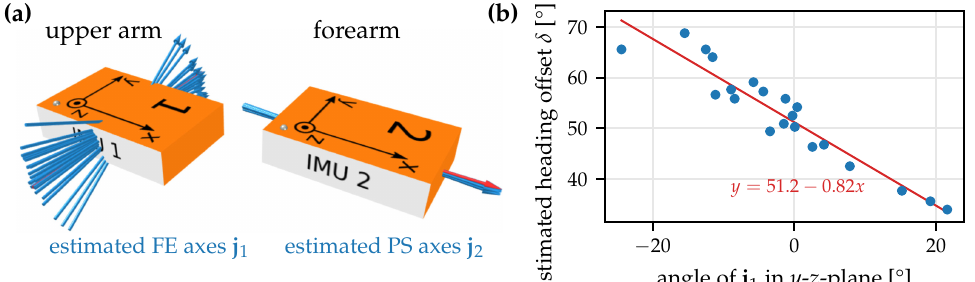
Figure 8. Investigation into the variability of the FE axis estimates (Subject 2, complex motion, rotation-based constraint). ( a ) 3D visualization of the axis estimates for all windows. ( b ) Plot of the estimated heading offset δ and the angle of the FE axis in the (approximately horizontal) y - z -plane of the upper arm IMU coordinate system. There is an obvious correlation, indicating that without sufficient upper arm movement, the kinematic constraint does not allow for distinguishing between a heading rotation of the joint axis and a heading offset between the sensor